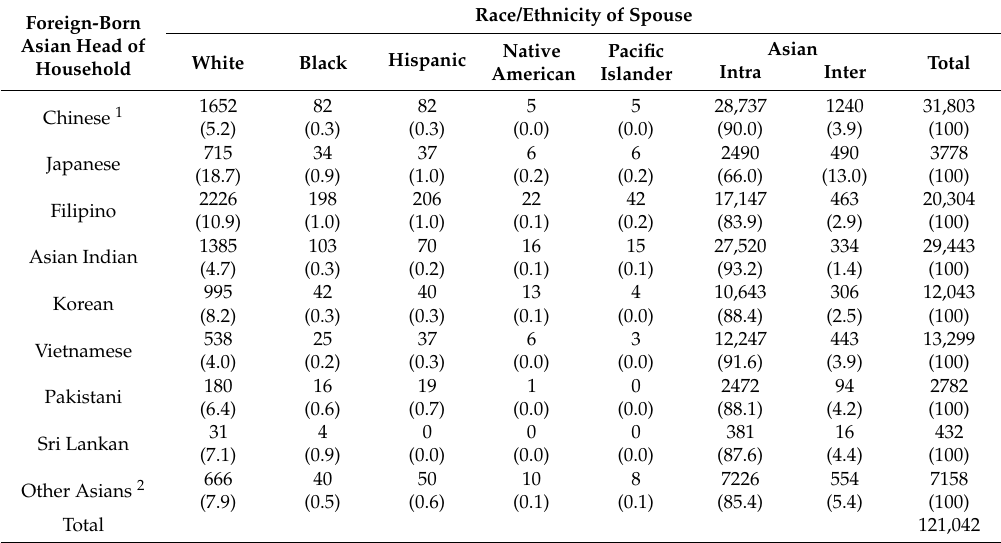
Table 2. Intermarriage Patterns of Foreign-Born Asian Household Heads by Asian Ethnicity and by Race or Ethnicity of Spouses, American Community Surveys (ACS)